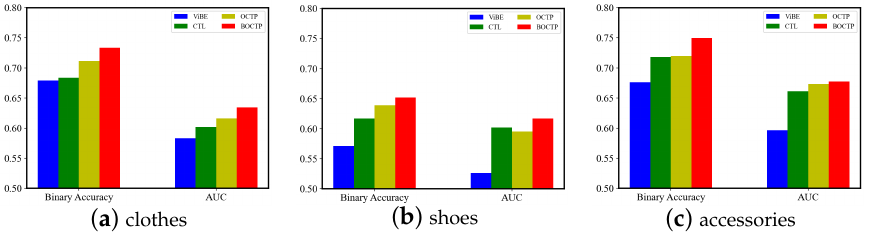
Figure 11. Ablation study on STL-Fashion ‘all’ dataset for label-given task. Binary Accuracy and AUC on clothes, shoes and accessories are shown in the figure.